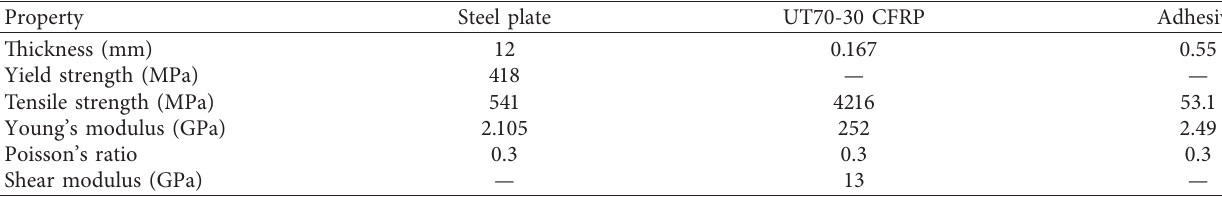
Table 1: Material properties in the